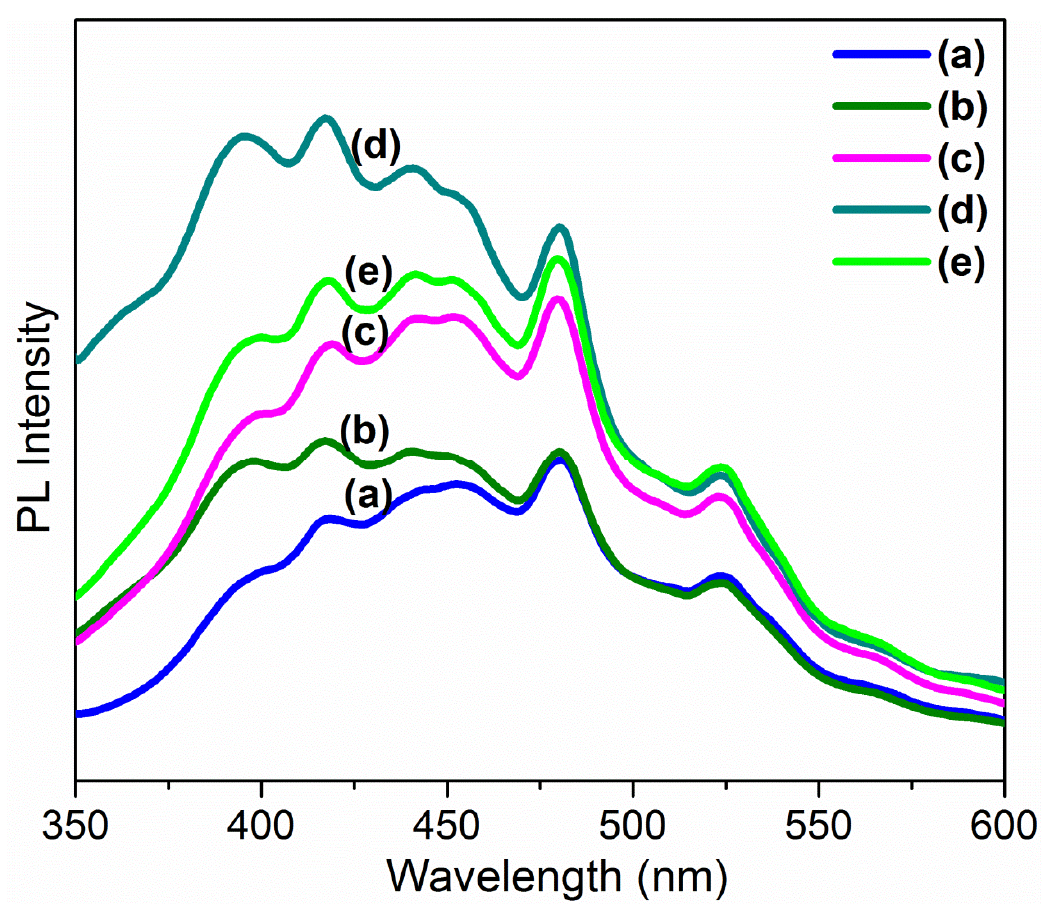
Figure 4. PL spectra of Fe doped MoO 3 thin films. ( a ) 0%, ( b ) 1%, ( c ) 2%, ( d ) 3%, ( e ) 4% of Fe con- centrations.